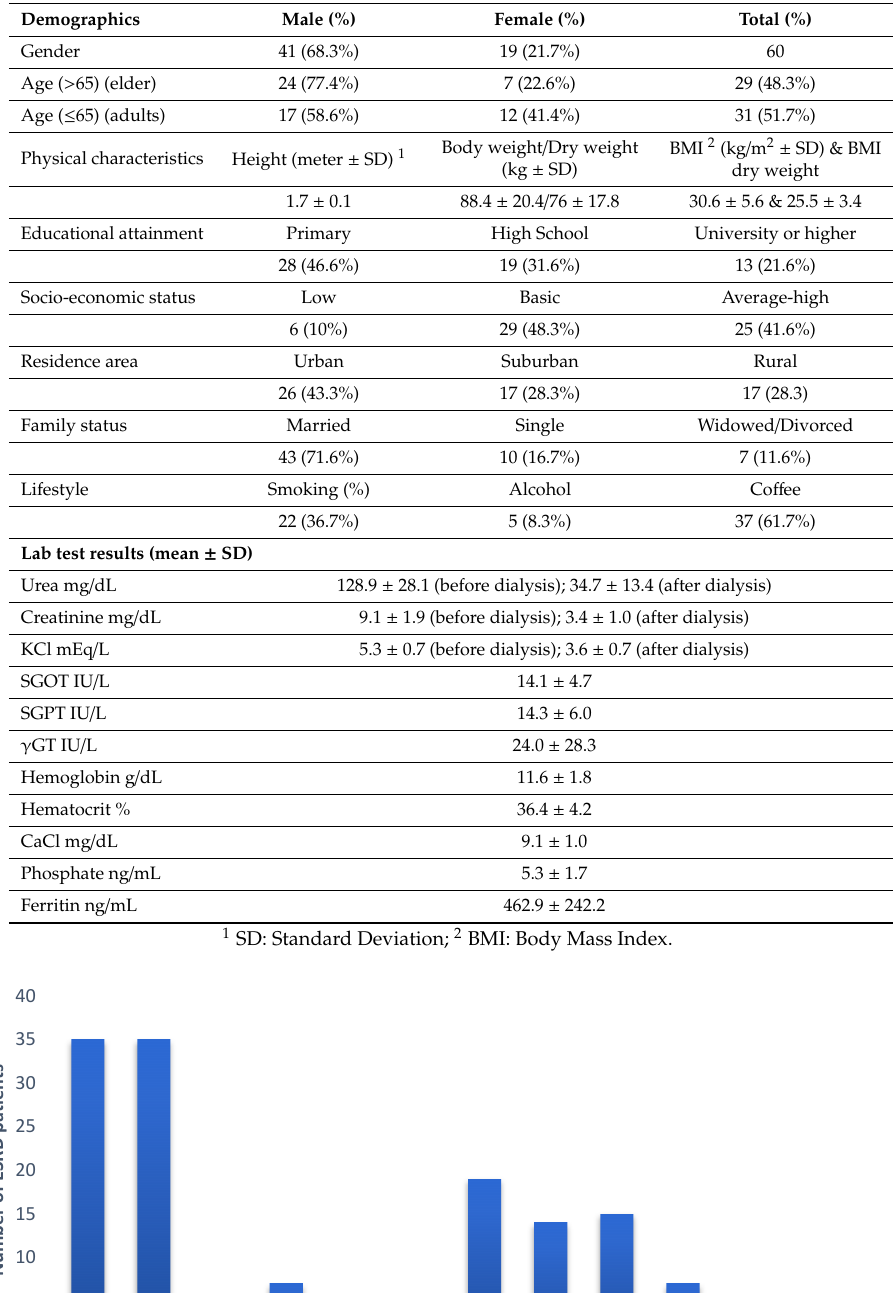
Table 3. Demographic characteristics and lab test results of ESRD patients in the study.